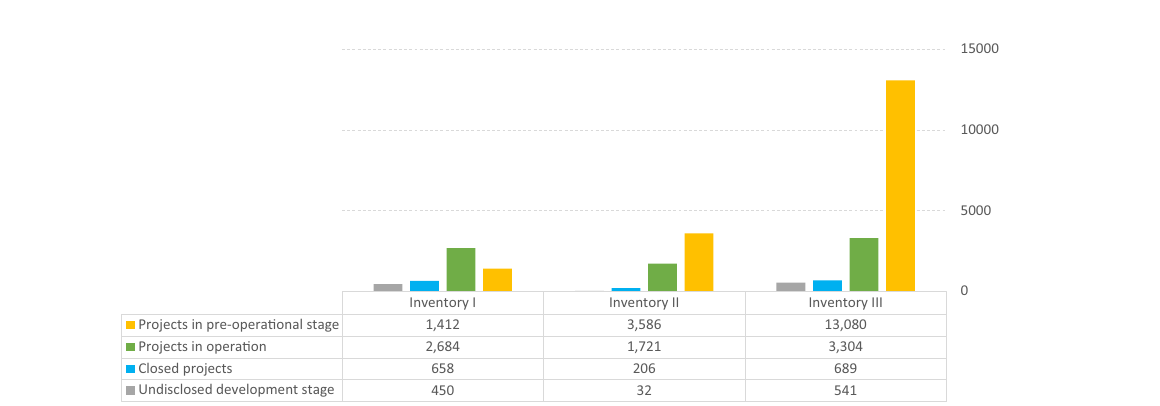
Fig. 3 | Inventories according to the development stage of mining projects. Inventory I includes coal mining projects. Inventory II includes energy transition metal projects where the calculation of Reserves and Resources are